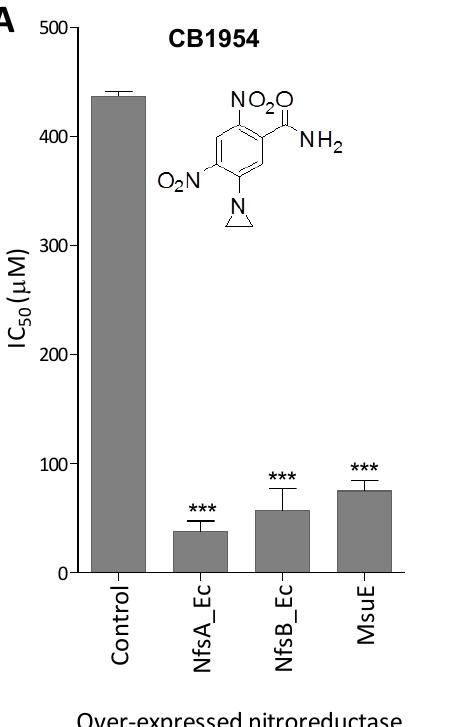
of HCT-116 50 ueous